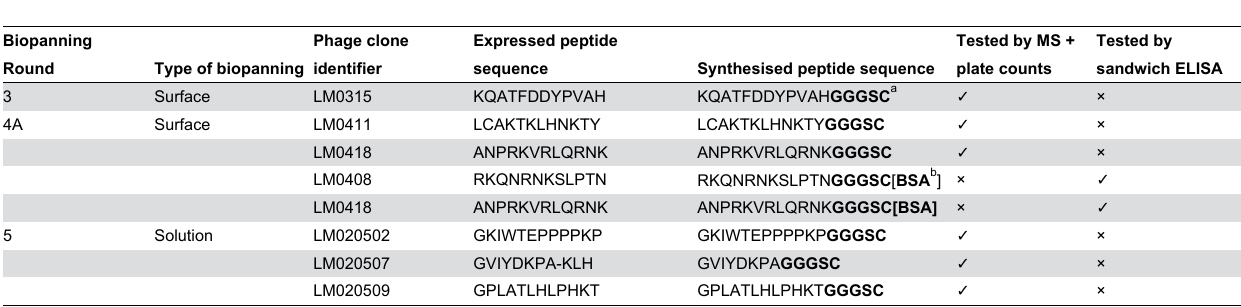
Table 3. Information on peptides chemically synthesised and evaluated for specific binding to L. monocytogenes 4b by either magnetic separation (MS) or sandwich